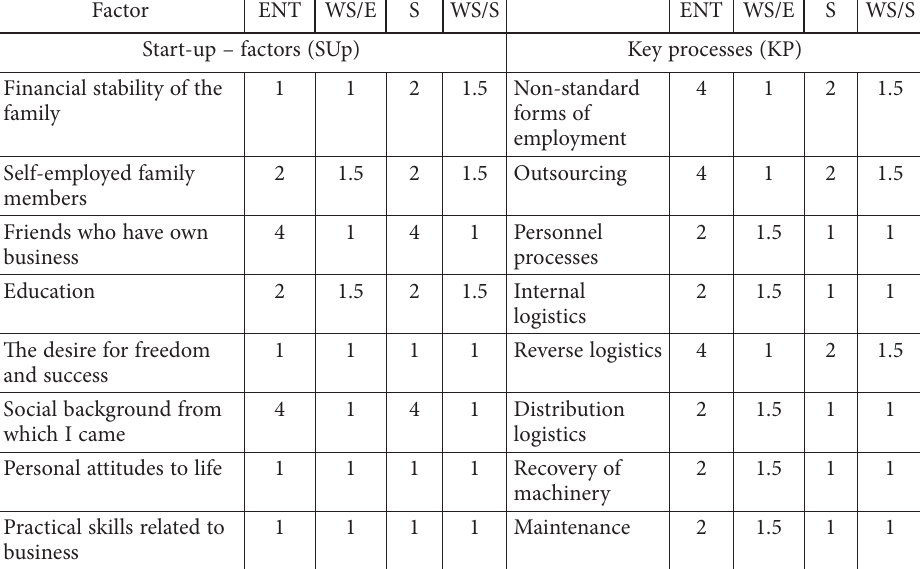
Table 8. Evaluation of the Czech competencies model (source: survey data mode values, differences are in bold, WS/S- weighted score students, WS/E- weighted score entrepreneurs) Factor ENT WS/E S WS/S ENT